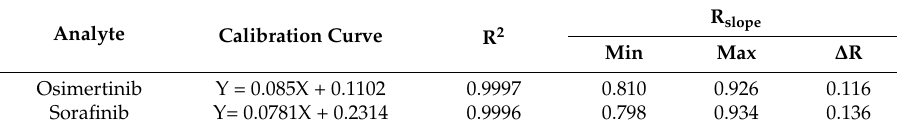
Table 3. The slope ratio of the solvent linear equation and the matrix linear equation.